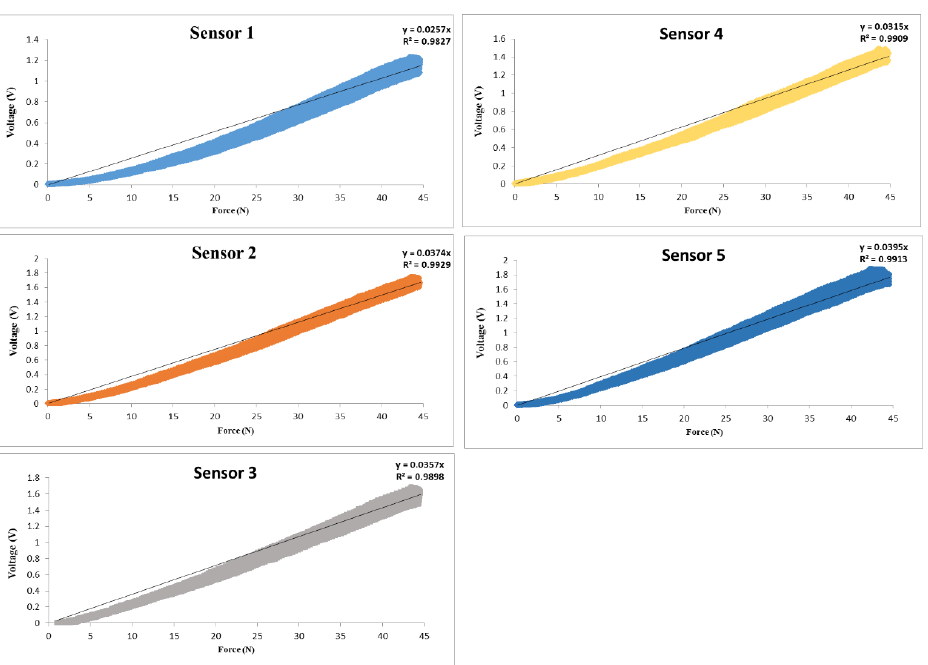
Figure 3. Dynamic calibration output voltage versus force of five pressure sensors.